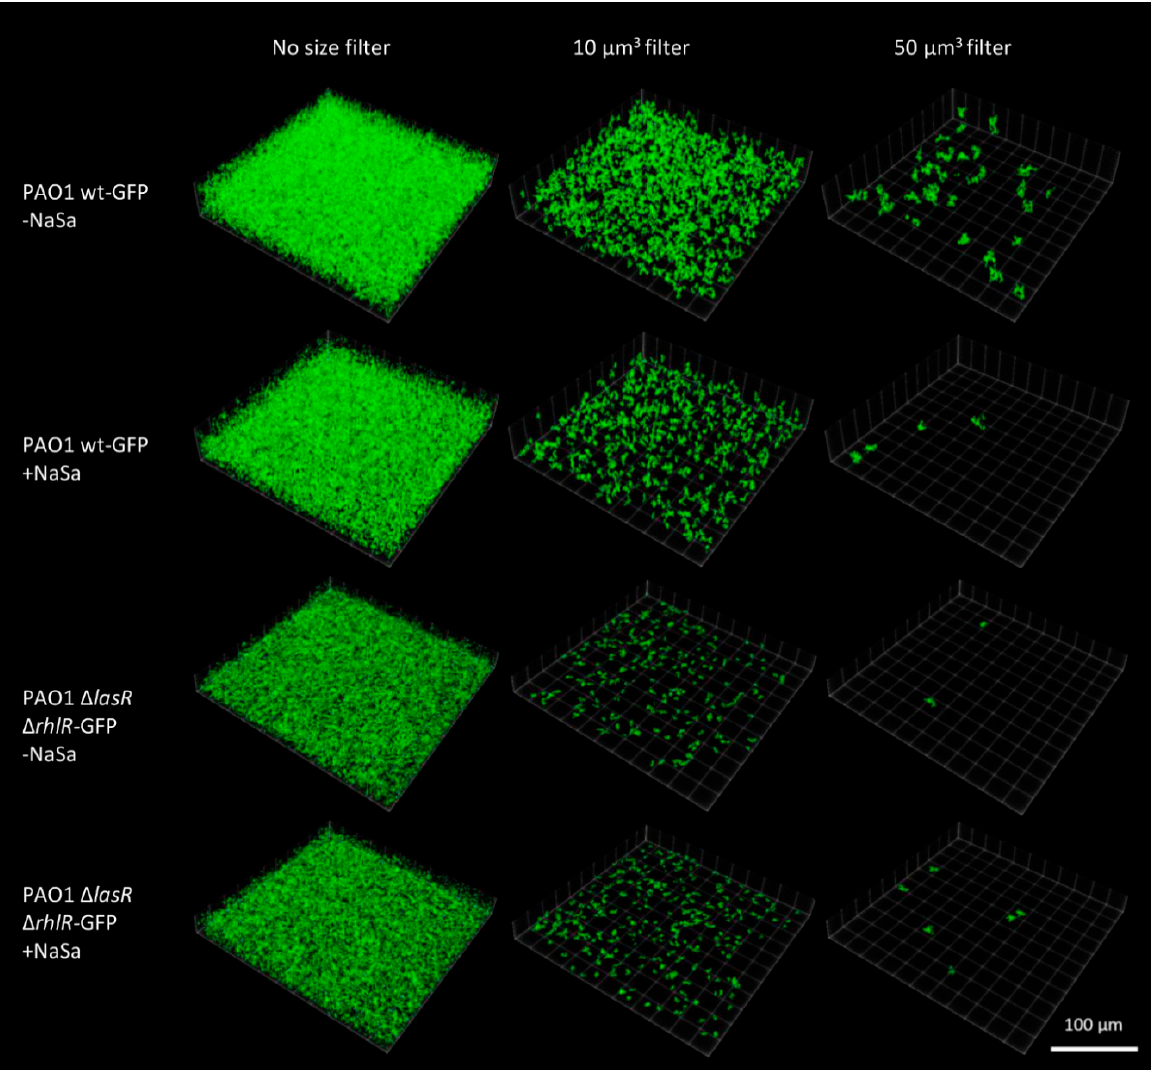
Figure 5. Visualization of 24 h biofilm aggregates on collagen type-I-coated glass slides. Aggregates of PAO1 wt-GFP and PAO1 ∆ lasR ∆ rhlR -GFP from representative image stacks, volume-filtered at 10 µ m 3 and 50 µ m 3